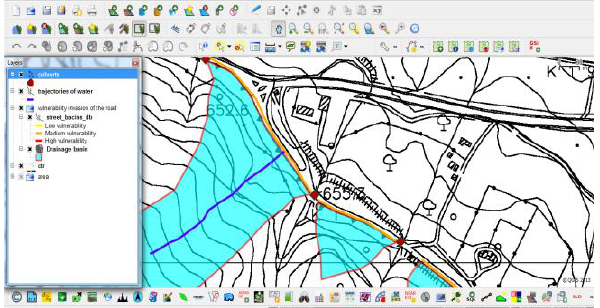
Figure 2. Construction of areas where water and debris flow directly over the road